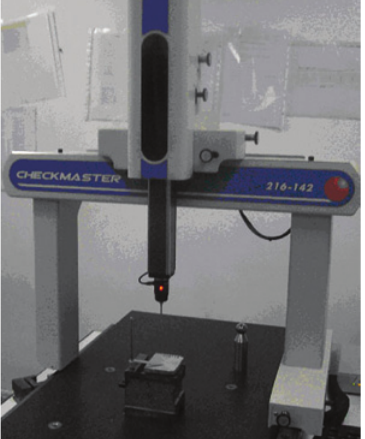
Figure 4 Coordinate measuring machine.